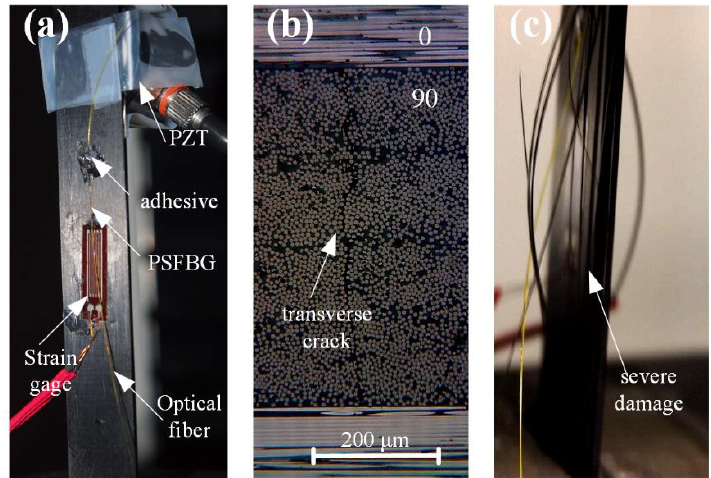
Figure 13. The acoustic emission detection in a tensile test. ( a ) the setup of AE detection using PSFBG; ( b ) transverse crack; ( c ) severe damage.